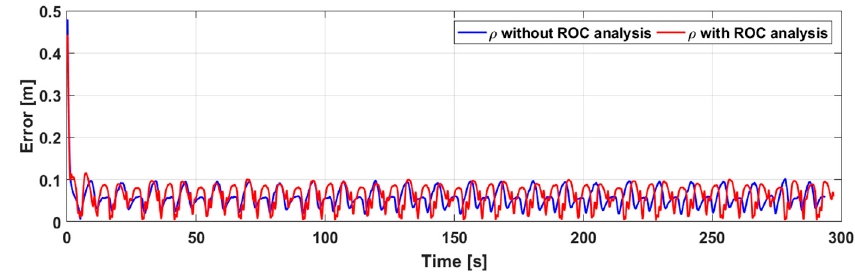
Figure 17. Total quadratic errors of the second experiment.